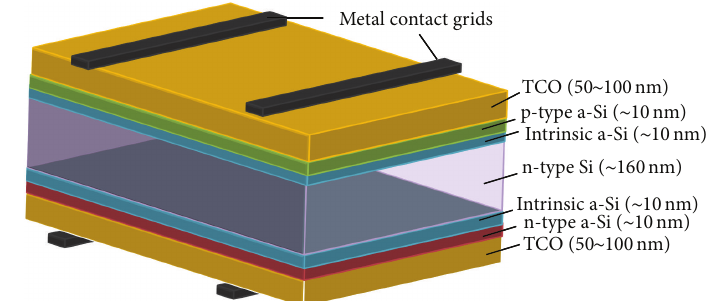
Figure 7: HIT solar cell structure.